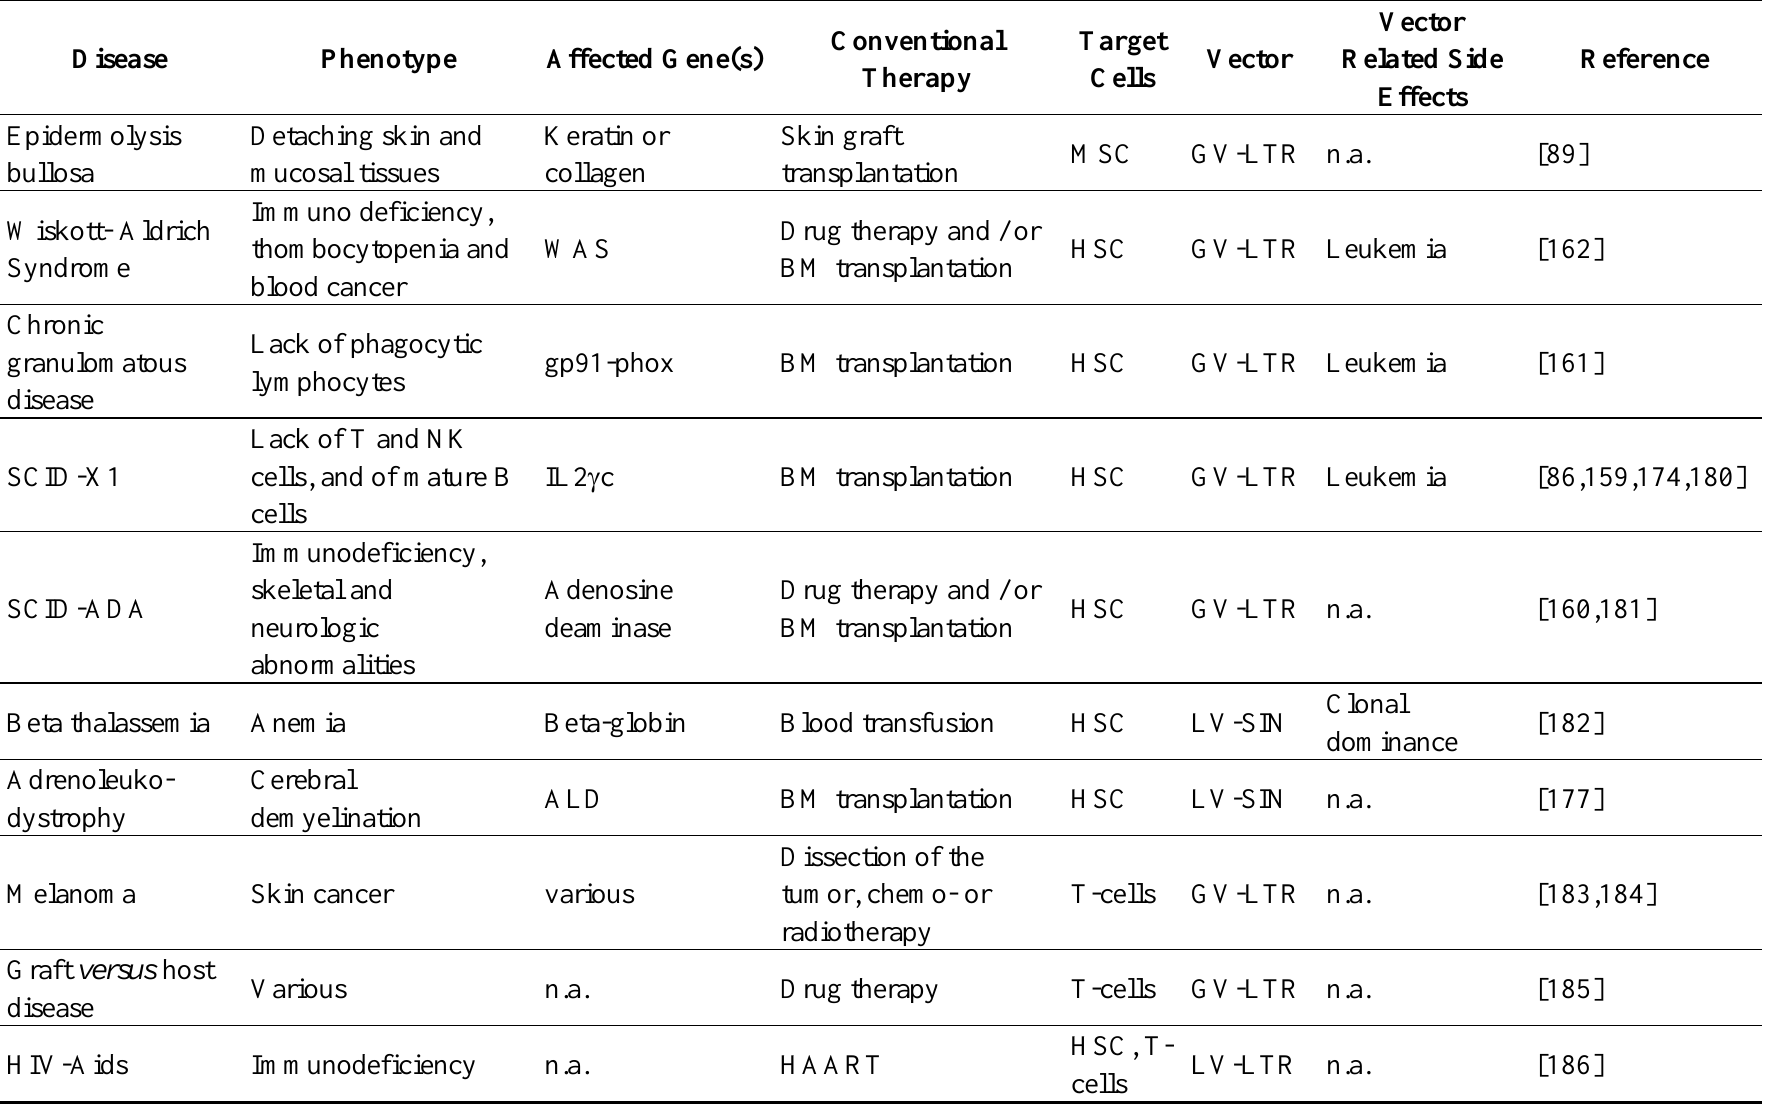
Table 2. Selected gene therapy trials targeting the hematopoietic system or skin